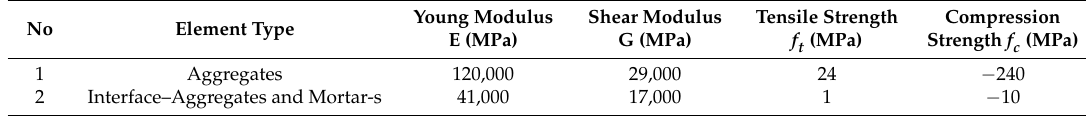
Table 8. Aggregate and interface material properties [41].